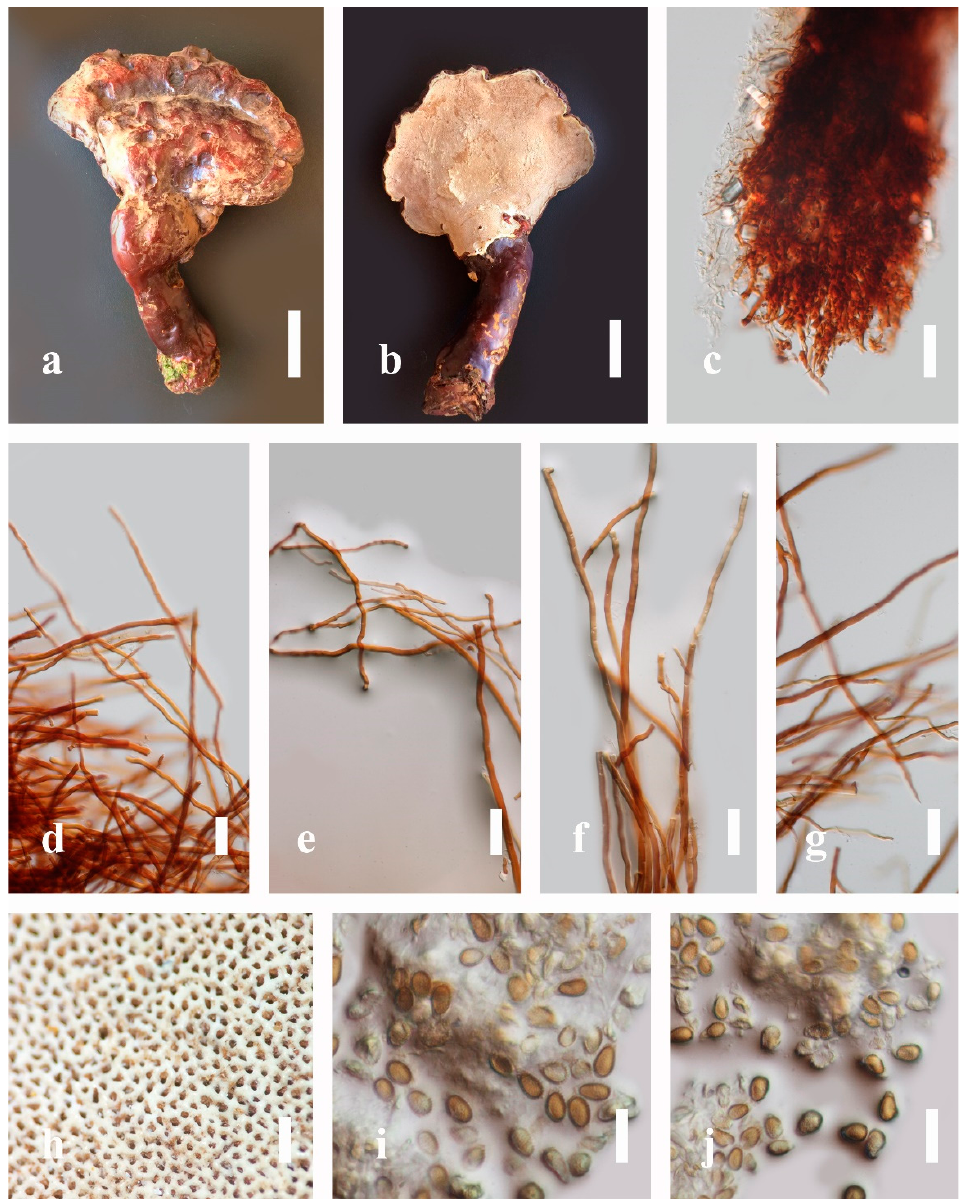
Figure 15 . Morphology of Ganoderma tsugae ( HKAS 97406 ) : ( a , b ) mature basidiomes; ( c ) hyphae of tube layers; ( d – g ) context hyphae in KOH; ( h ) pore characteristics; ( i , j ) basidiospores . Scale bars : ( a , b ) = 4 cm, ( c ) = 30 cm, ( d – g ) = 30 µm, ( h ) = 500 µm, ( i , j ) = 5 µm .